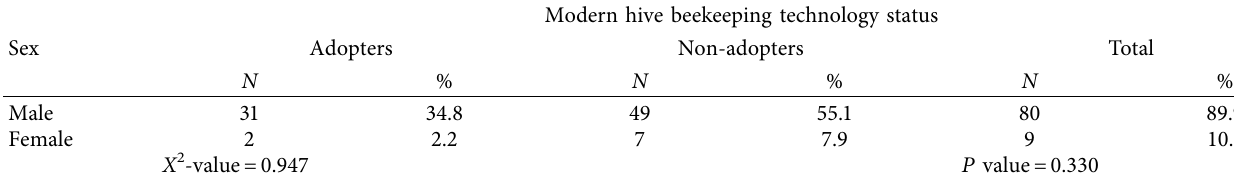
Table 3: Sex distribution of the household head.